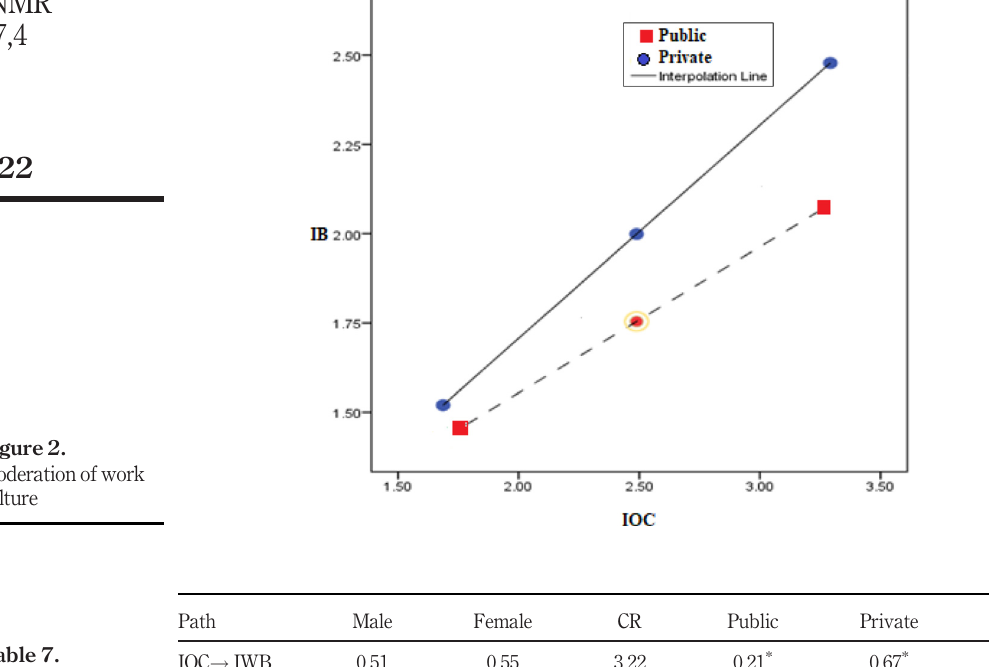
Path Male Female CR Public Private Table 7. Path coef fi cient ’ s comparison